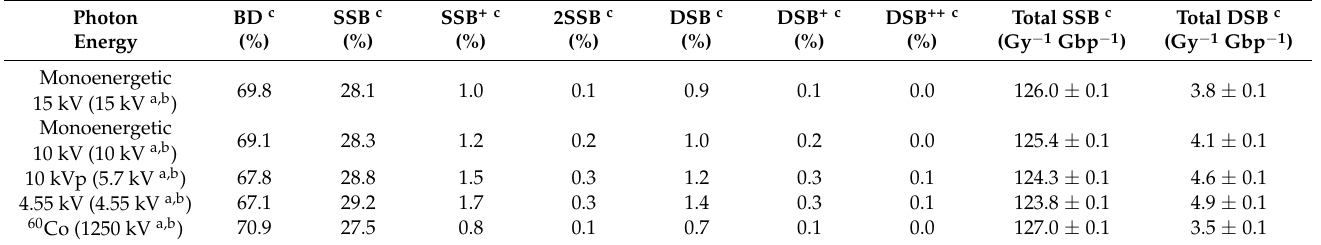
Table 5. Relative yield of DNA damage and absolute yield of DSB and SSB (per Gy per Gbp) (mean ± standard error) at a hypoxic oxygen concentration of 0.1%).